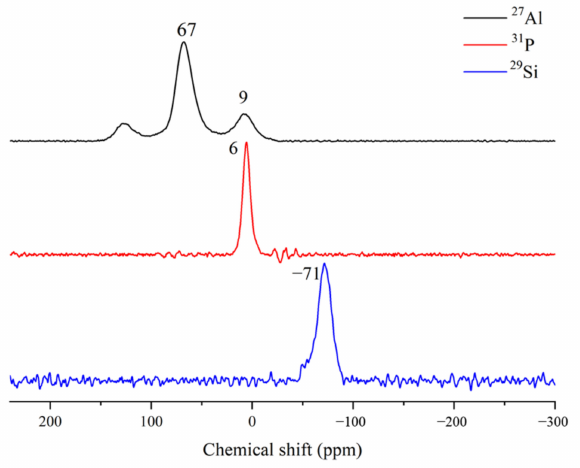
Figure 7. NMR spectra of 27 Al, 29 Si, and 31